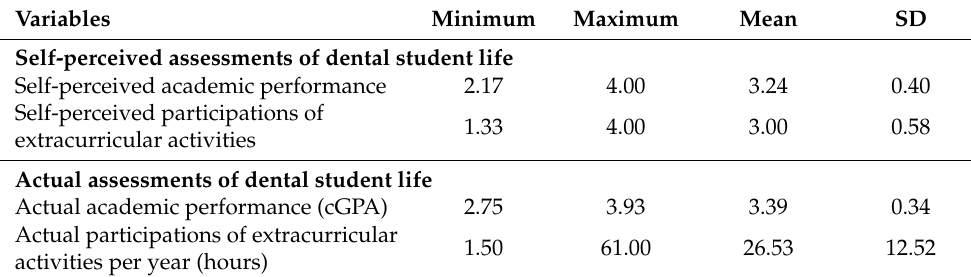
Table 3. Assessments of dental student life.